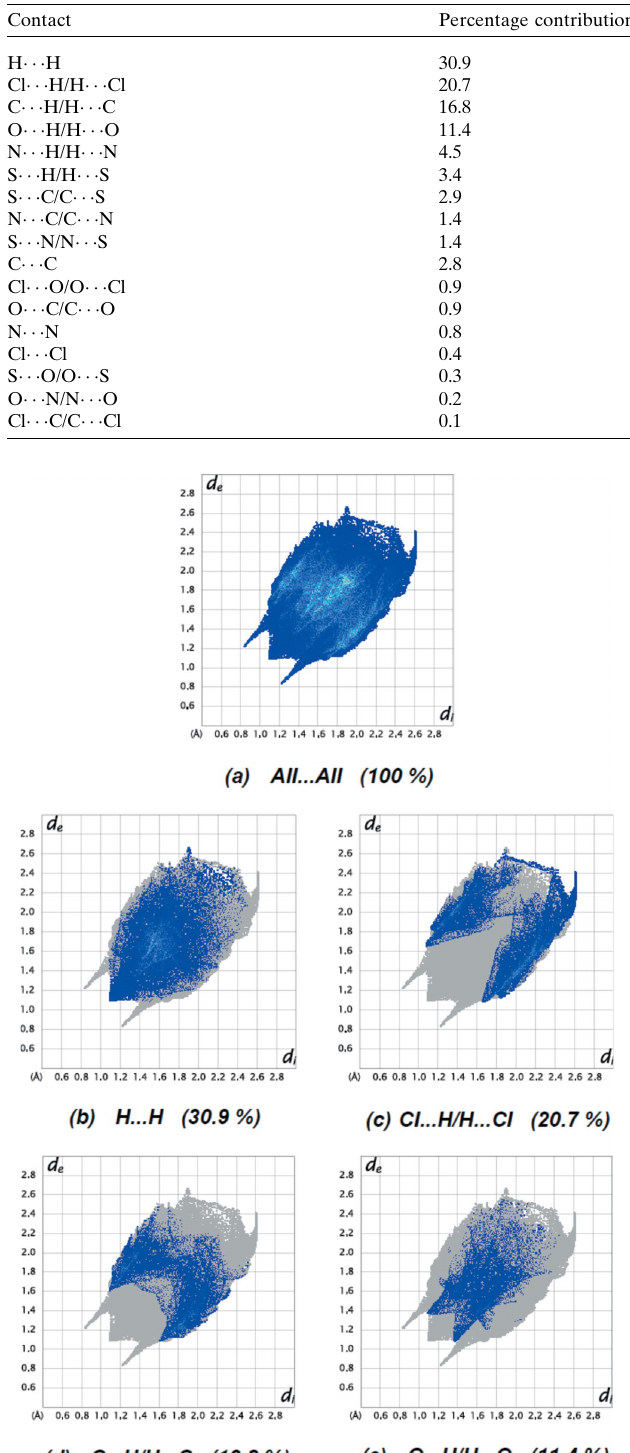
Table 3 Percentage contributions of interatomic contacts to the Hirshfeld surface for the title compound.